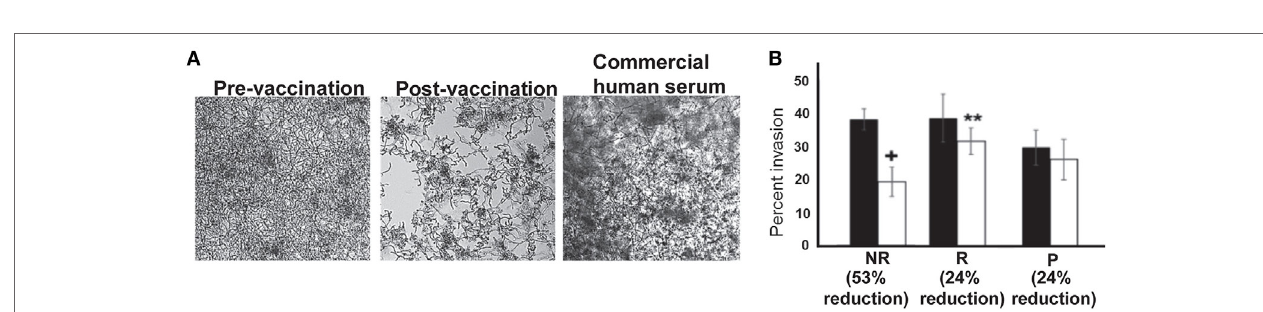
FigUre 4 | In vitro assessment of Candida albicans filamentation, and invasion of vaginal epithelial cells in presence of patient sera. Representative micrographs (from six different samples in each arm) showing that post-vaccination sera from non-recurrent (NR) patients who abrogated biofilm formation displayed short and wavy hyphae, compared with the normal robust hyphae in the biofilms formed in pre-vaccination serum, or the control commercial pooled human serum (a) . Six samples from placebo or NDV-3A-vaccinated patients (three R and three NR) were selected from Figure 2D (open symbols) for analysis in invasion of vaginal epithelial cells. Post-vaccination sera from NR patients inhibited invasion of vaginal epithelial cells twofold more than R patient or P patient sera (B) . ** p < 0.01 for post- vs. pre-vaccination sera from R patients. + p < 0.05 for post-vaccination sera vs. pre-vaccination sera from NR and vs. post-vaccination sera from R or placebo patients. Data in (B) are presented as mean ± SD.